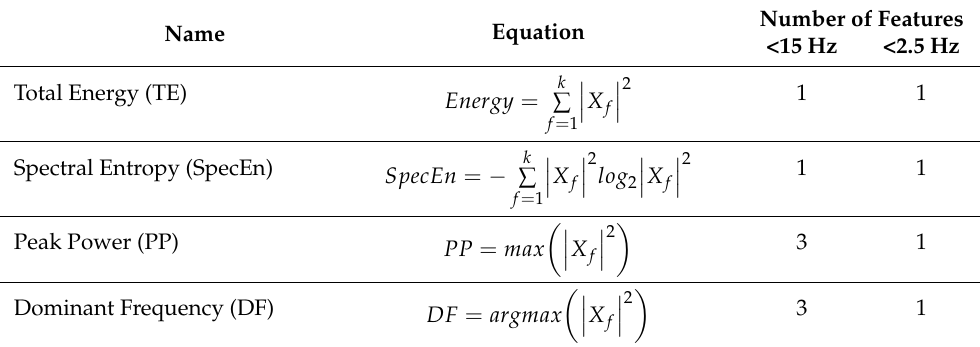
Table 2. Spectral features extracted from the x, y, and z axes of accelerometer data. Each feature was extracted from two sets of the PSDs, X f was obtained using STFT: one in the frequency range of 0–15 Hz and another in the frequency range of 0–1.5 Hz. The function argmax indicates the index of the maximum value in the